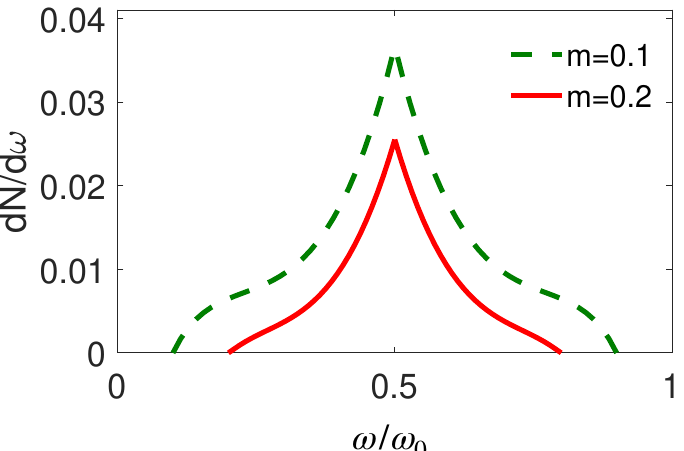
Figure 4. The energy frequency of vacuum radiation, where the prefactor TS q 0 are set to be